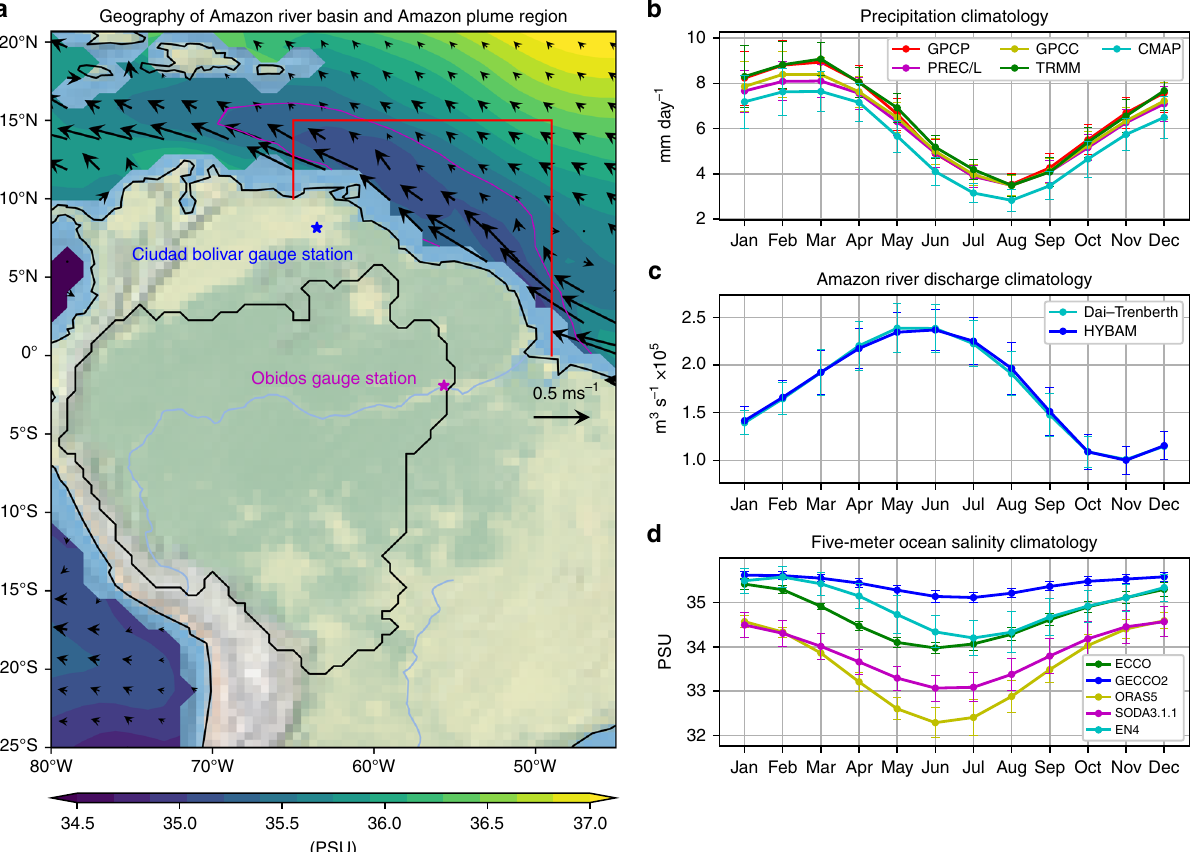
Fig. 1 Relationships between the seasonal cycles in Amazonia precipitation, Amazon river discharge, and Amazon plume region (APR) ocean salinity. a The geographic domain of Amazon river basin (black contour line) and APR (red box). The color shading over the ocean represents annual mean 5-m ocean salinity with 34.5 PSU countered as magenta, and the black arrows denote annual mean 5-m ocean current velocities. The magenta and blue stars denote the location of the Obidos and Ciudad Bolivar gauge stations, where Amazon and Orinoco river discharges were recorded, respectively. b Long-term mean (1979 – 2018) of observed precipitation averaged over the Amazon river basin in each month. Note that the mean TRMM precipitation is averaged over 1998 – 2018. c Long-term mean of Amazon river discharge (1979 – 2018) at Obidos and Dai and Trenberth river discharge (1979 – 2014) in each month. d Long-term mean of 5-m ECCO4 (1992 – 2017), GECCO2 (1979 – 2016), ORAS5 (1979 – 2018), SODA3.3.1 (1980 – 2015), and EN4 (1979 – 2018) ocean salinity averaged over the APR in each month. The error bars in b , c , and d indicate the standard deviations of each month throughout the analysis period. The geographic map is produced by Python Cartopy package 77